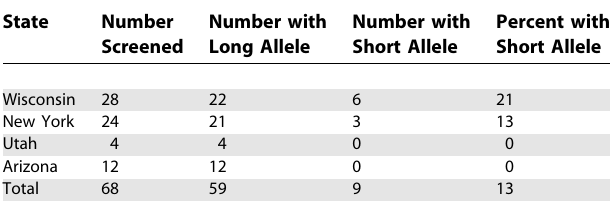
Table 1. Frequency of ibpA Promoter Alleles in Buchnera of Field-Collected Pea Aphids from Localities in North America State Number Screened